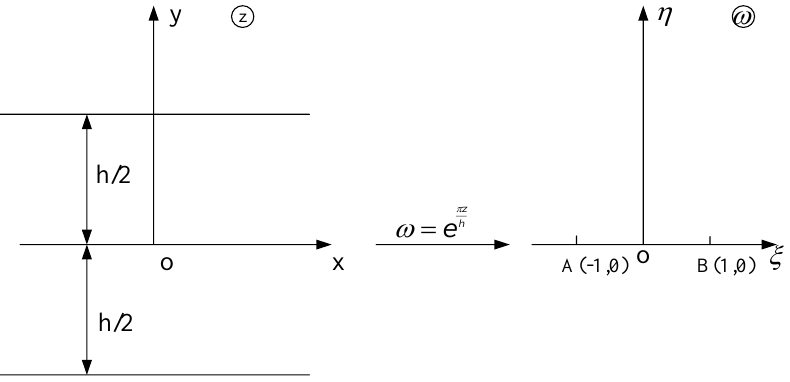
Figure 3—Vertical conformal